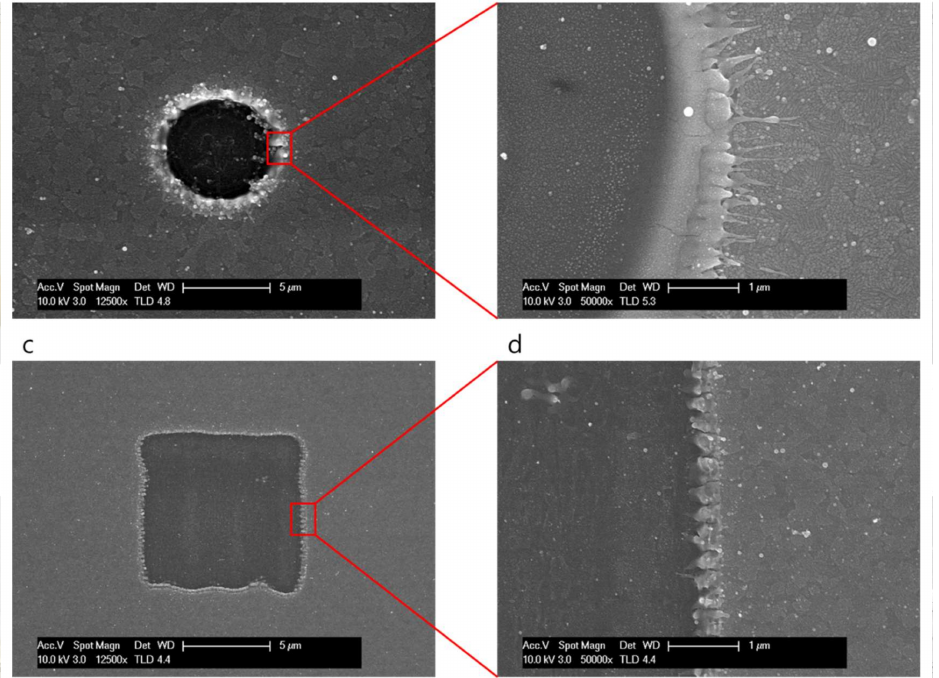
Figure 2. ( a ) Scanning electron microscope (SEM) image of ablation with the Gaussian beam profile; ( b ) Enlarged SEM image of the ablated edge with Gaussian beam irradiation; ( c ) SEM image of ablation with the quasi-flat top beam profile; and ( d ) Enlarged SEM image of the ablated edge with quasi-flat top beam